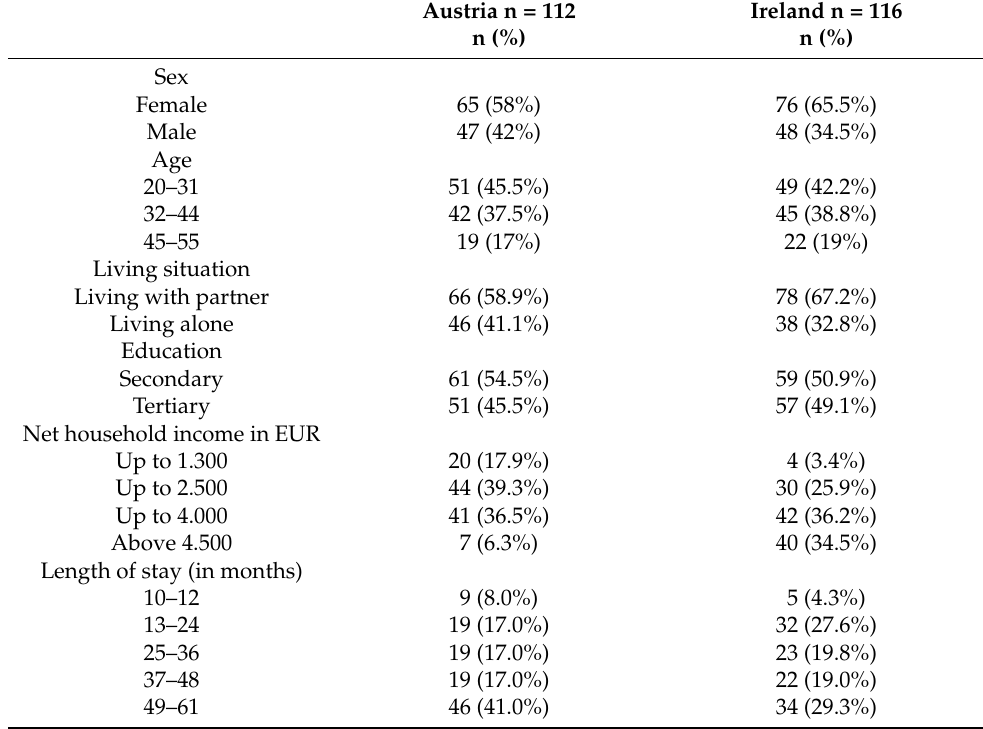
Table 4. Sociodemographic characteristics of the